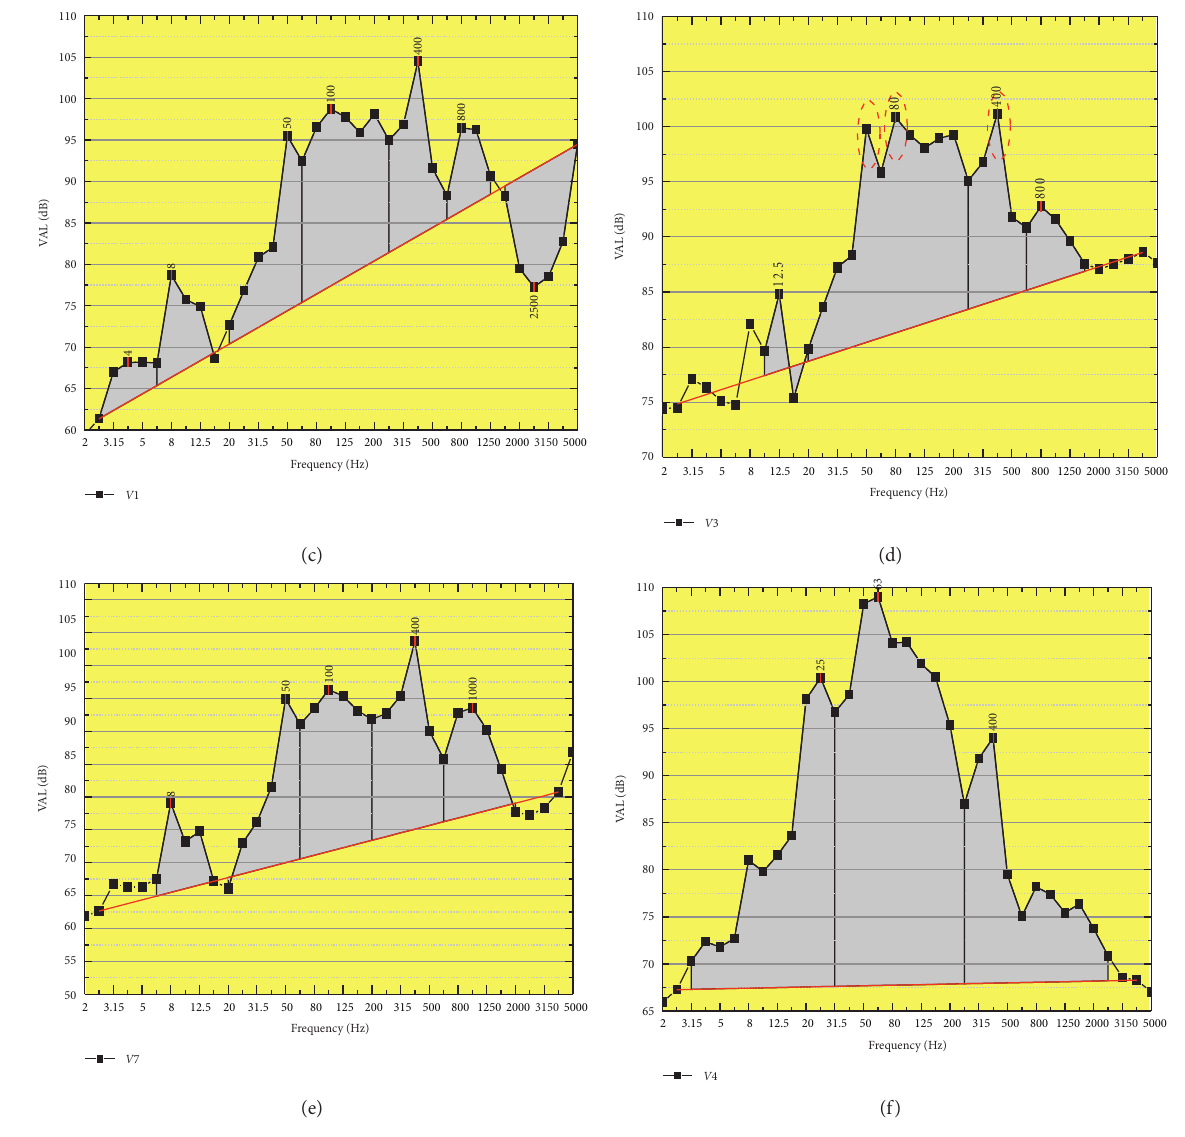
Figure 9: 1/3-octave analysis of the bridge-FESB